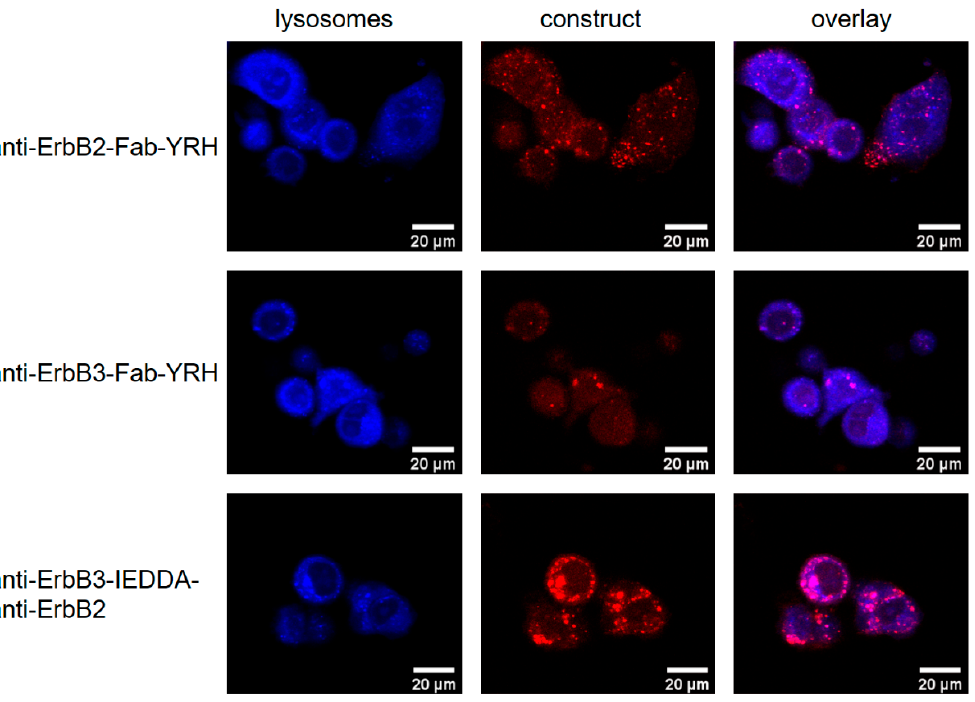
Figure 6. Internalization of anti-ErbB3-IEDDA-anti-ErbB2-bsFab compared to the single anti-ErbB2- and anti-ErbB3-Fab by lysosome-stained SKBR-3 cells after 24 h. Lysosomes were stained with LysoBriteBlue, single and bispecific Fabs were modified with AlexaFluor568 NHS ester. IEDDA: inverse electron-demand Diels–Alder reaction.